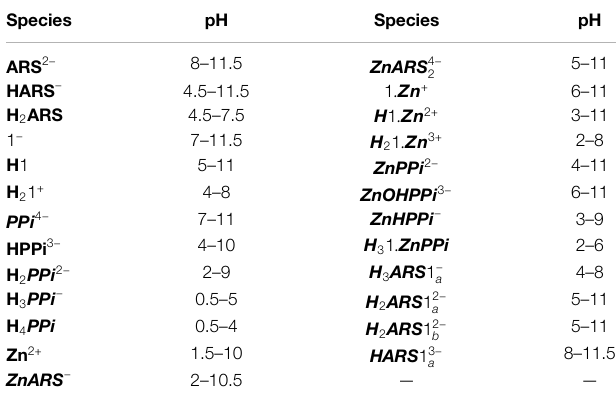
TABLE 4 | The pH presence window for the species of Scheme 1